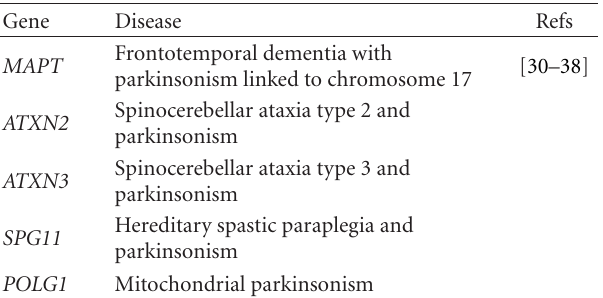
Table 1: Loci and genes associated with familial PD. Table 2: Additional genes causing